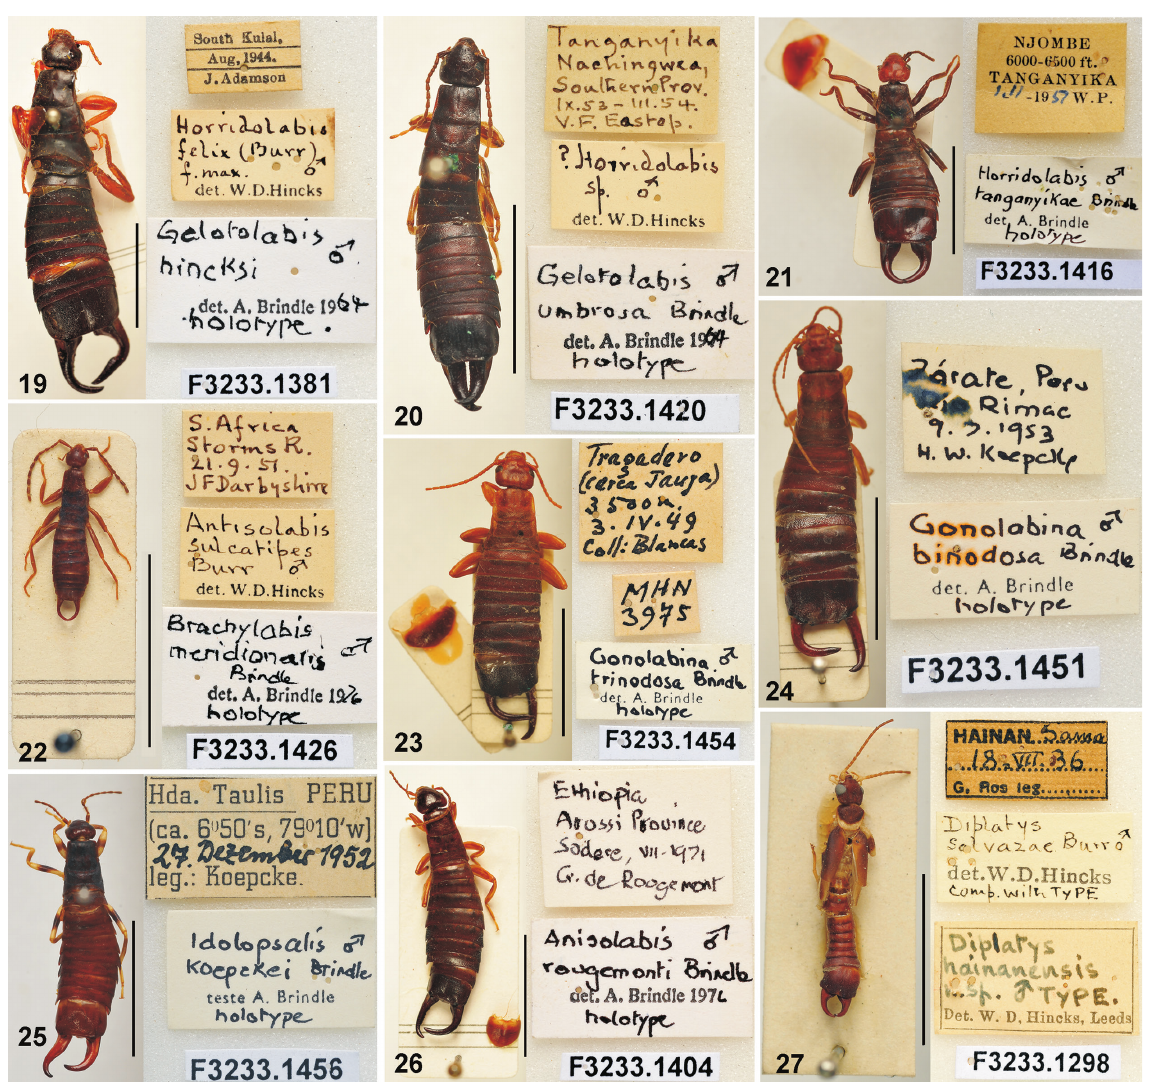
Figs 19–27. Holotypes (♂) of Anisolabididae and Diplatyidae in the collection of the Manchester Museum. 19 . Gelotolabis hincksi Brindle, 1964 (now Gonolabis hincksi ). 20 . G. umbrosa Brindle, 1964 (now Gonolabis umbrosa ). 21 . Gelotolabis tanganyikae Brindle, 1964 (now Gonolabis tanganyikae ). 22 . Brachylabis meridionalis Brindle, 1978 (now Antisolabis meridionalis ). 23 . Gonolabina trinodosa Brindle, 1967. 24 . G. binodosa Brindle, 1967. 25 . Idolopsalis koepckei Brindle, 1966. 26 . Anisolabis rougemonti Brindle, 1978. 27 . Diplatys hainanensis Hincks, 1940 (now Paradiplatys salvazae ). Scale bars = 1